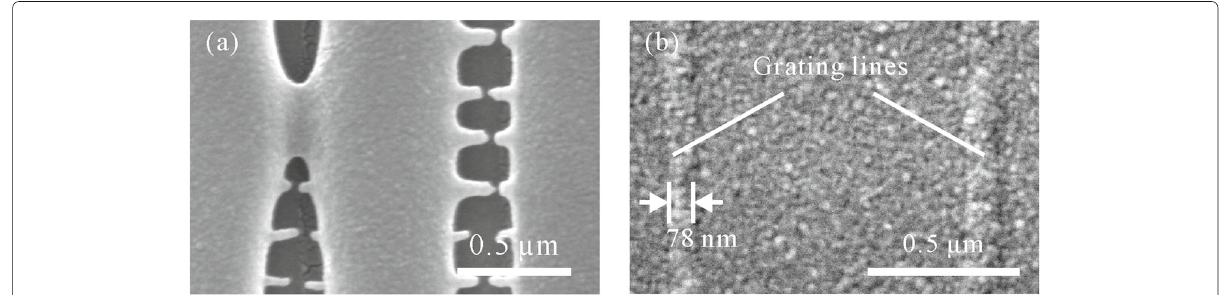
Fig. 6 The influence of laser focus positions on structure formation. Material: E-shell 300. a Vertical grating lines fabricated with laser focus more inside the photoresist. The laser intensity for fabrication I = 0.71kW/ μ m 2 (corresponding to laser power 1.55mW), the relative laser focus distance (cid:6) z = 500nm. Extra polymerization between the features is generated, and the adjacent features are connected. b Vertical grating lines fabricated with laser focus more inside the substrate. The laser intensity for fabrication I = 0.65kW/ μ m 2 (corresponding to laser power 1.4mW), the relative laser focus position (cid:6) z = 0nm